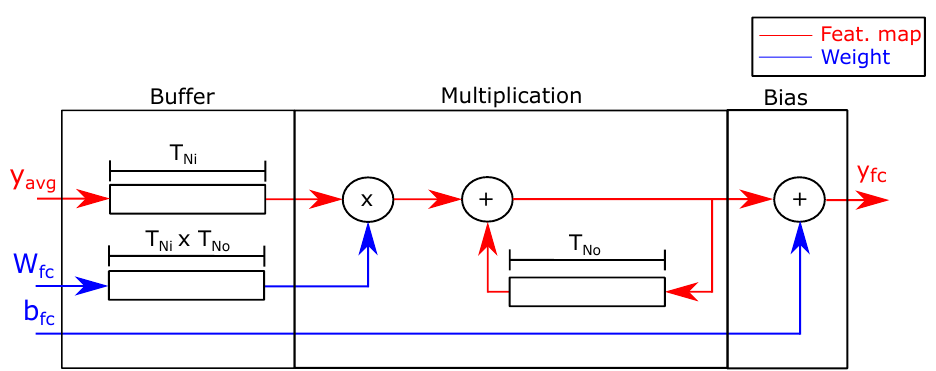
Figure 8. Average pooling FU.